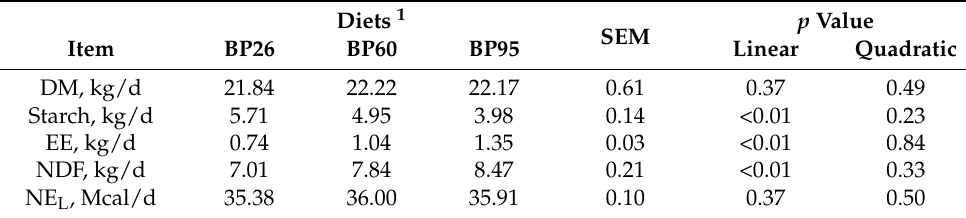
Table 3. Effect of replacing human-edible feed ingredients with byproducts on nutrient